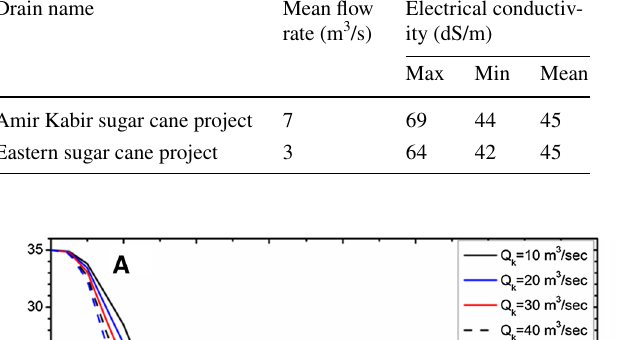
Table 1 Electrical conductivity of the drainage water entering the Karun river from some of the large sugar cane projects (Ghadiri 2016) Drain name